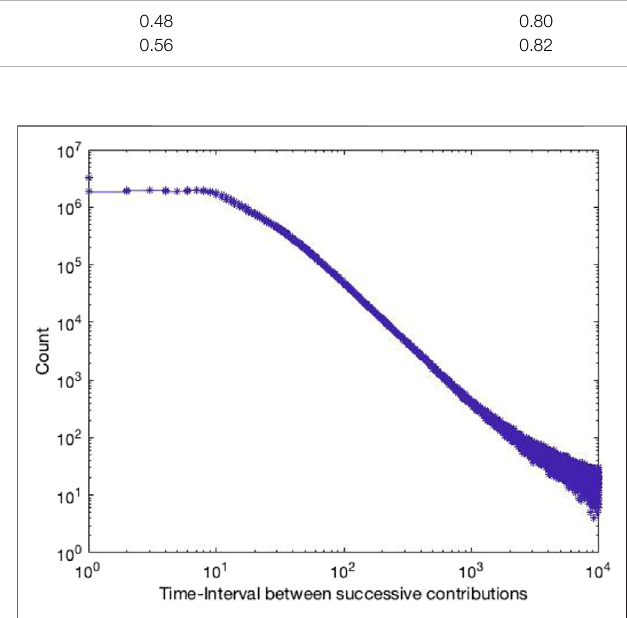
FIGURE 3 | Distribution of time-intervals between successive contribution by the same citizen